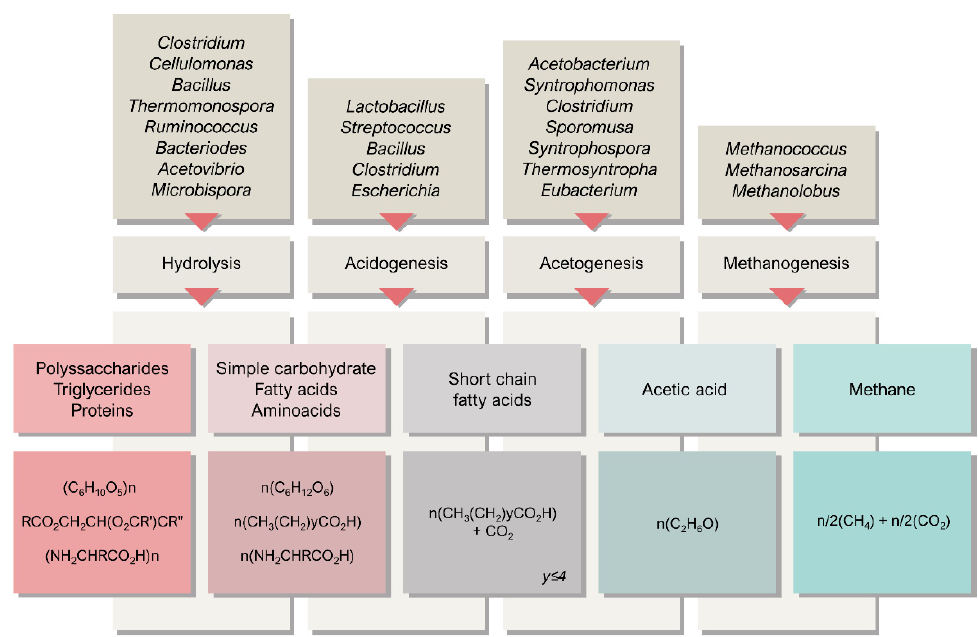
Figure 1. The role of the most common microorganisms in the anaerobic microbiota of a mesophilic biodigester. R, R ′ , and R ″ are organic radical groups, while n and y denote the number of biomolecules or radicals of its composition [92,97].